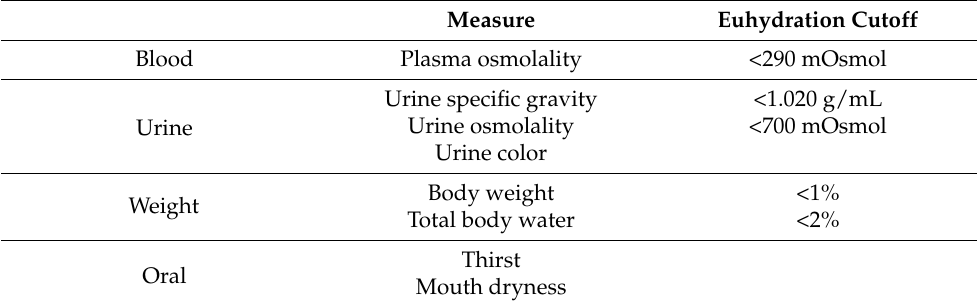
Table 1. Assessment of dehydration